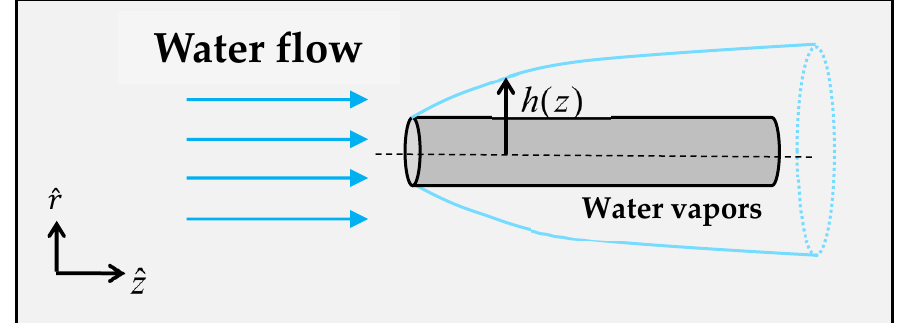
Figure 1. A scheme of the physical problem.